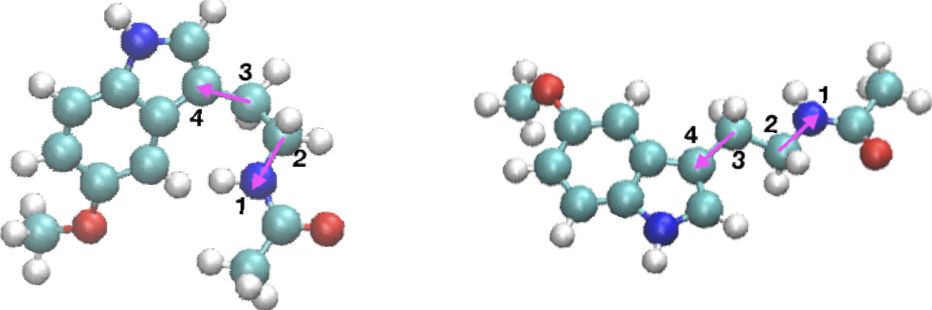
Figure 6. Two principal configurations of MEL: folded ( left ) and extended ( right ), indicated by the dihedral (torsional) angle Ψ . The atoms forming the melatonin molecule are: carbon (cyan), oxygen (red), hydrogen (white), and nitrogen